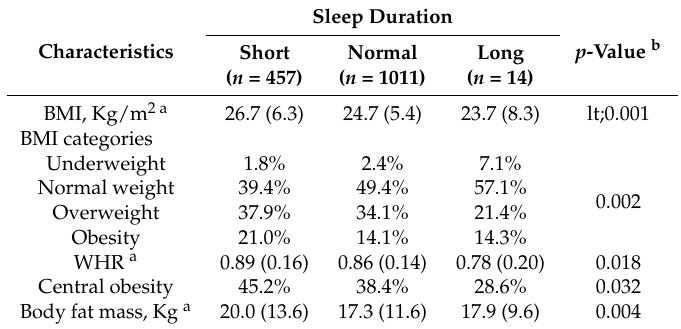
Table 2. Anthropometric measures and indices of obesity by categories of sleep duration.